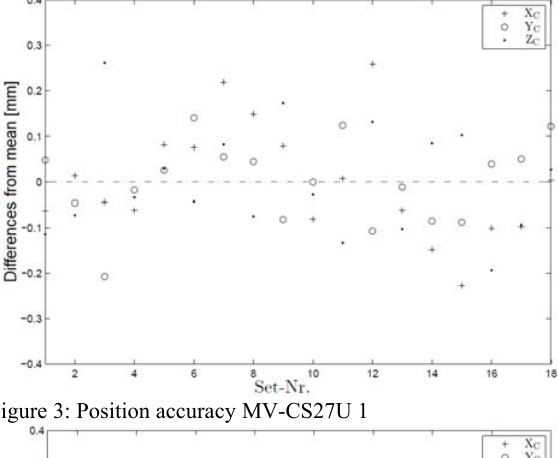
Figure 3: Position accuracy MV-CS27U 1